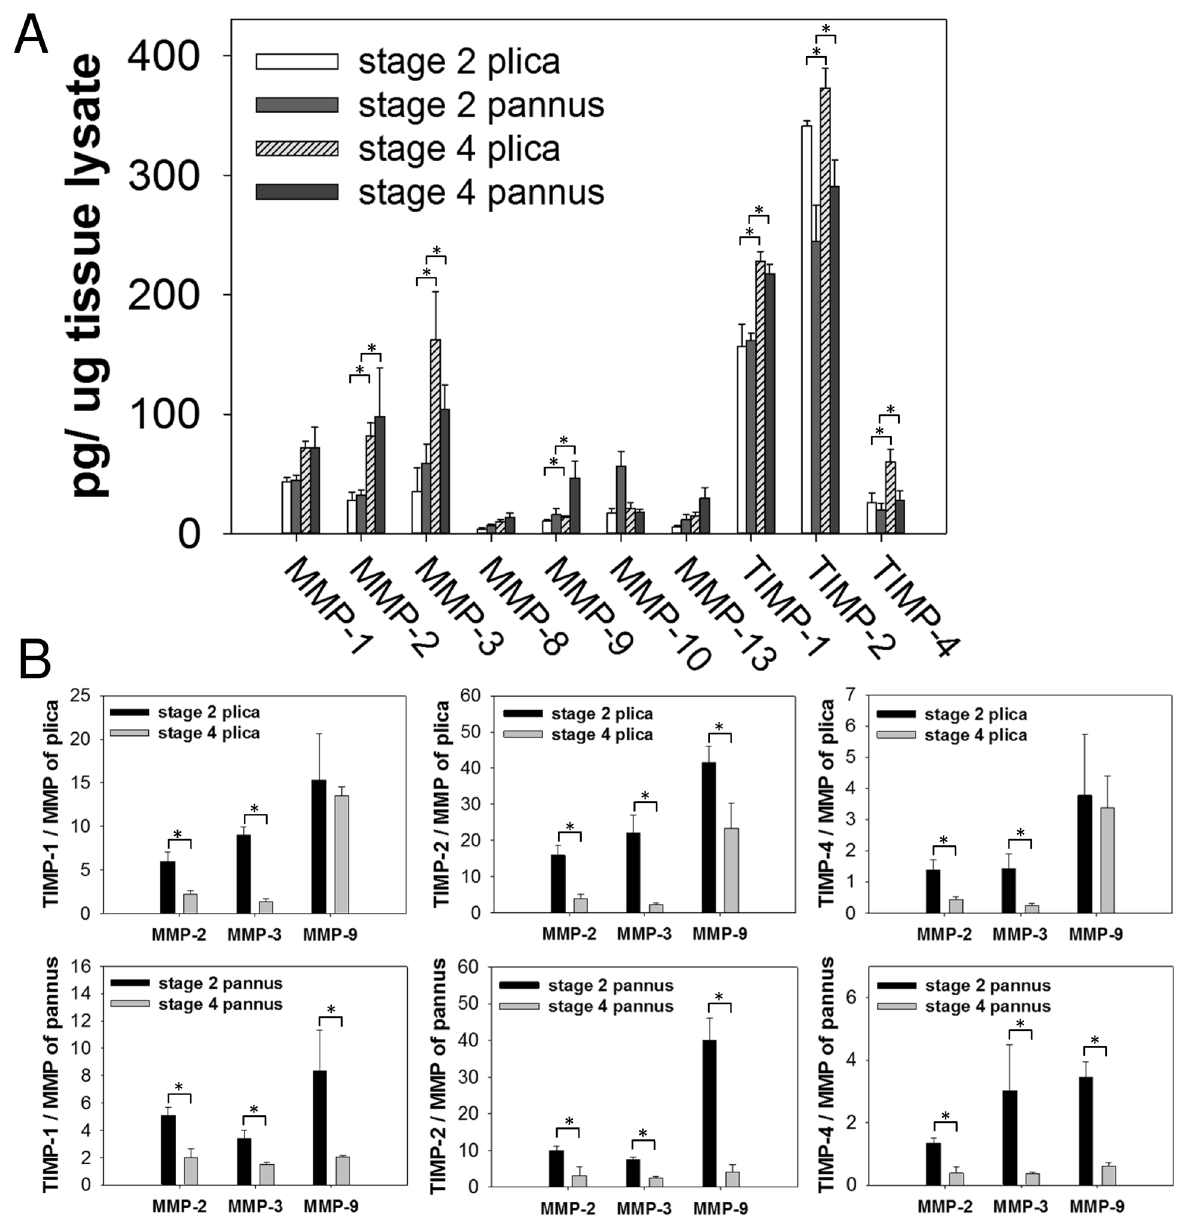
Figure 1. MMP and TIMP levels in lysates of medial plica and pannus-like tissue from OA patients. (A) Measurement of human MMP-1, MMP-2, MMP-3, MMP-8, MMP-9, MMP-10, MMP-13, TIMP-1, TIMP-2, and TIMP-4 using a Quantibody ® human MMP ELISA array. The data are the mean ± standard deviation (SD) (N = 15), *P < 0.05. (B) TIMP/MMP ratios in lysates of stage II and stage IV plica (upper panels) and pannus (lower panels) calculated from the Quantibody® human MMP array results. The data are the mean ± SD (N = 15), * P < 0.05. doi: pannus-like tissues from stage IV OA patients. As shown in tissue from stage IV patients for MMP-2, MMP-3, and Figure 3, all three proteins were highly expressed in plica and MMP-9 pannus-like tissues from stage IV OA patients, but not in normal cartilage. Staining using normal rabbit IgG instead of Immunohistochemical staining was used to localize the expression of MMP-2, MMP-3, and MMP-9 in plica and